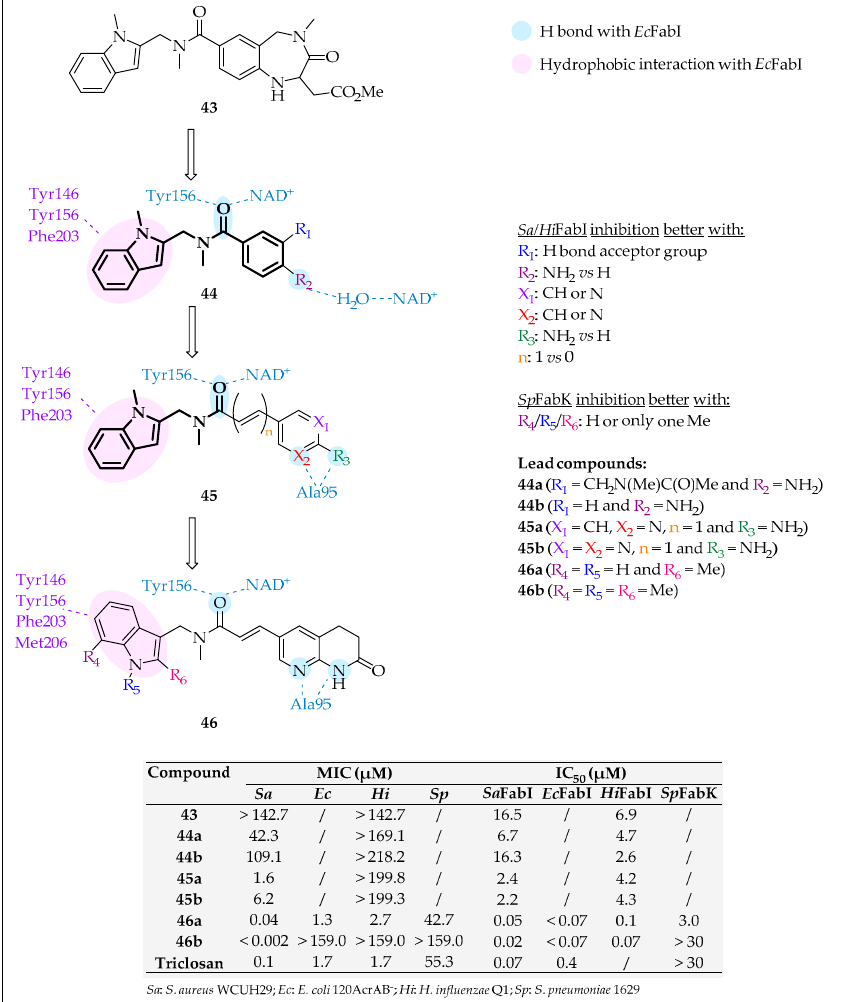
Figure 36. Structure, SAR and representation of main interactions with Ec FabI of 43–46 and in vitro activities of lead compounds